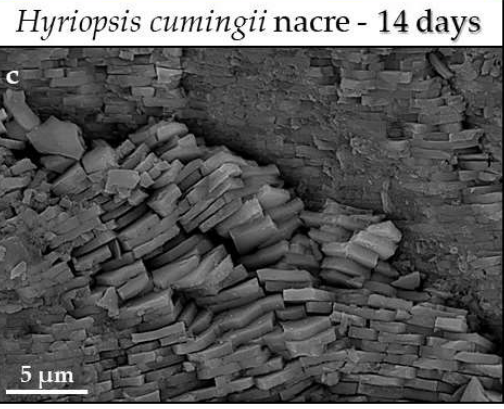
Figure 3. FE-SEM images of Hyriopsis cumingii nacre after ( a , b ) 4 days of conversion and ( c ) 14 days of conversion. Very little conversion to AP has taken place, the original arrangement of nacre tablets is well preserved ( c ). Even though, slight dissolution of aragonite induced that the surface of the nacreous shell layer became encrusted with a thin layer of newly formed AP crystals ( a , b ).